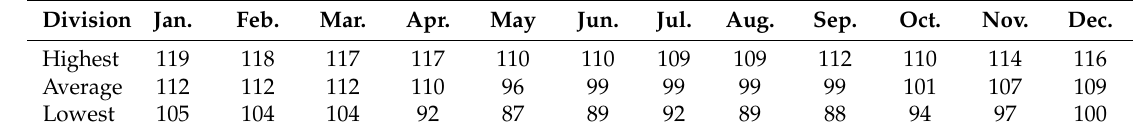
Table 1. Supply temperature (unit: ◦ C).